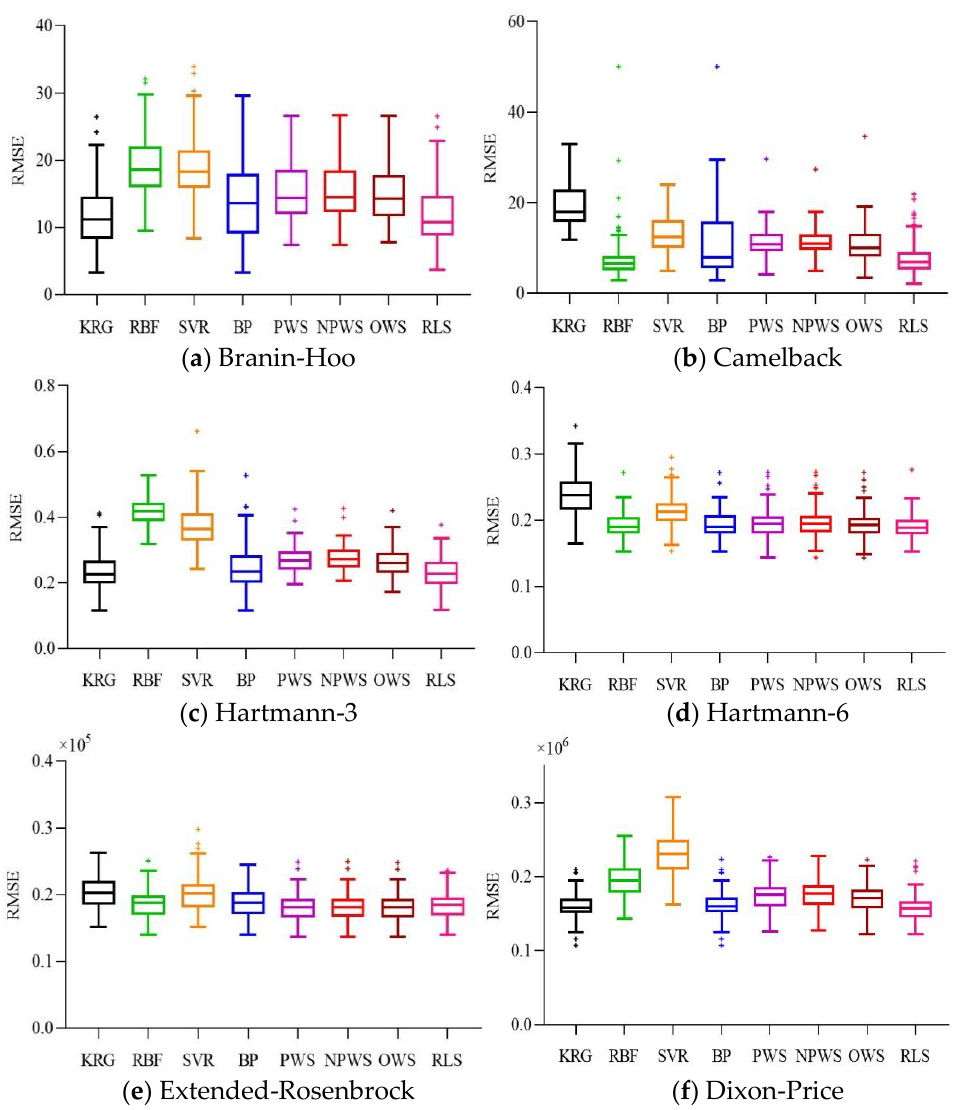
Figure 3. Boxplots of RMSE for the six numerical examples.